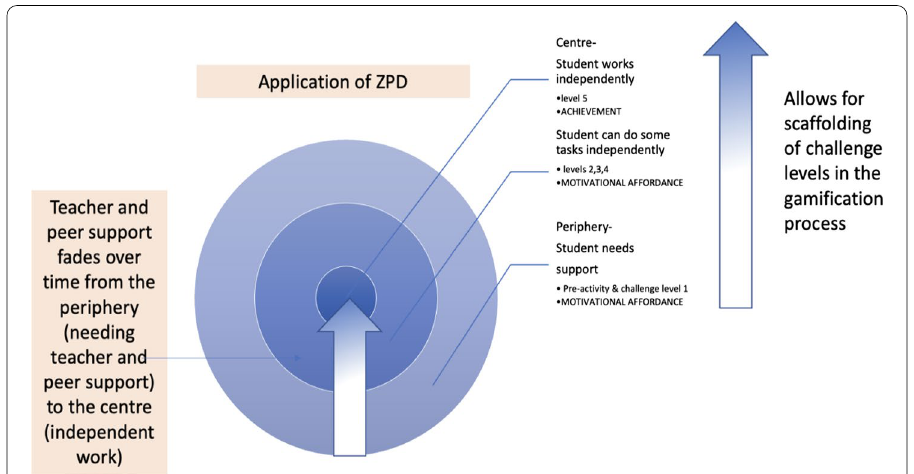
Fig. 2 Conceptual Framework for Gamification